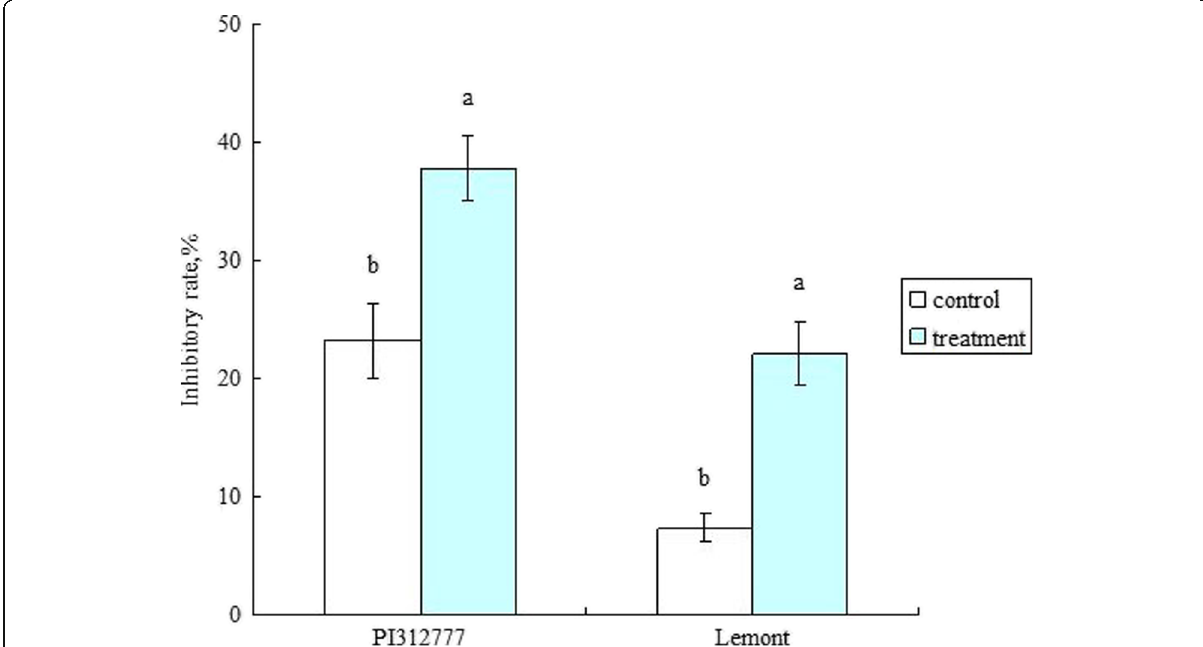
Fig. 1 Inhibitory rate of the rice culture solutions on lettuce root length. The bars represent the standard errors of the mean ( n = 4). Different letters indicate significant differences at P <